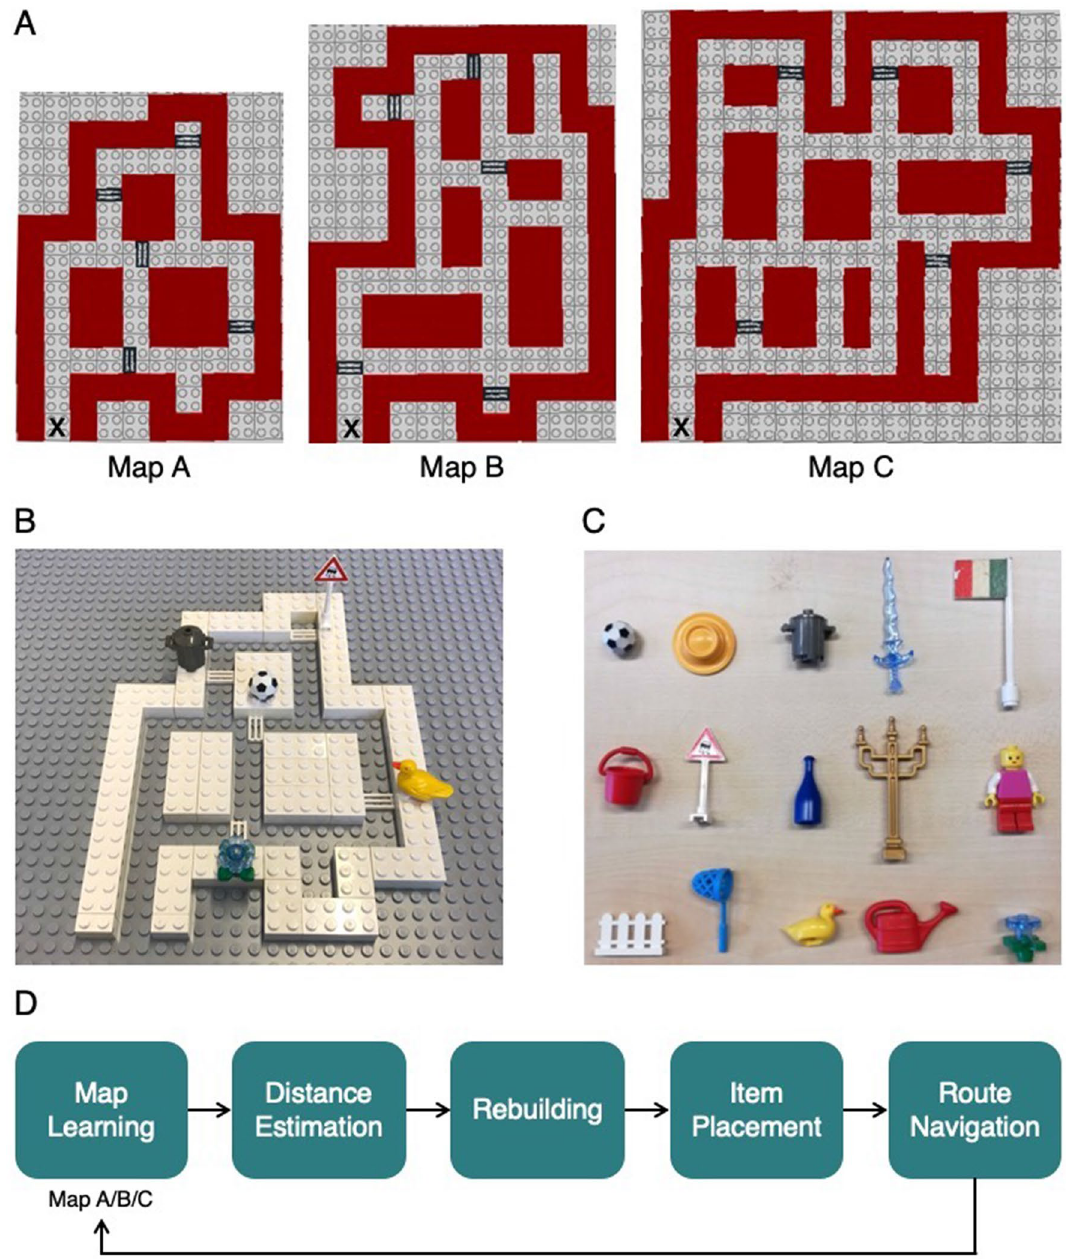
Figure 1. The tactile maps. ( A ) Top view of the three tactile maps and the items. Map A, B and C have 7, 11, and 15 intersections respectively. The five item locations are shown on each map (striped rectangles). The start locations are indicated with an ‘x’. ( B ) An example of map A including placement of the items. ( C ) The 15 used items. ( D ) Order of the five tasks that are performed for all three All tasks were explained before the start of the experiment, so participants knew what was going to happen before each part. Participants in the H group were visually occluded by a curtain during all tasks, while the VH group was never vision-restricted. Both groups always received the same instructions. At the end of the experi- ment, participants were asked about their learning strategies and whether they feel they performed better on the last map because of experience. They were also asked about wayfinding in unfamiliar environments in daily life: whether they plan the route beforehand and try to form a mental map, whether they use a navigational app while navigating in the environment, or a mixed strategy.